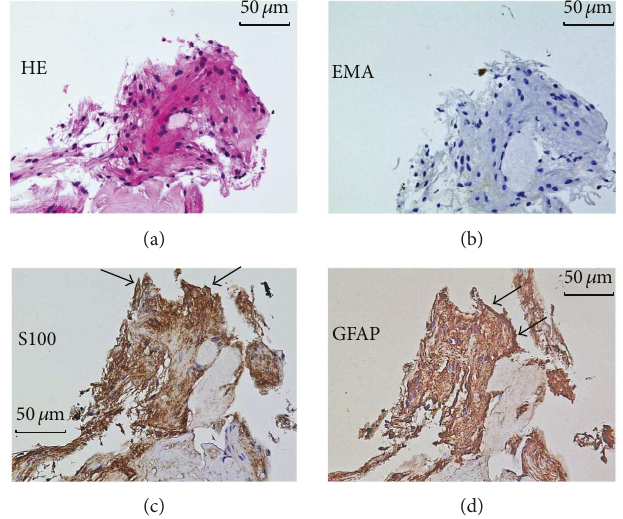
Figure 7: Histology (a) and immunohistochemistry (b – d) of a resected epipapillary membrane tissue in case 4. (a) Light micrograph demonstrating marked hyalinization. Spindle-shaped stromal cells were intermingled in the section (hematoxylin-eosin). (b) Immunochemistry for cytokeratin. Immunoreactivity was not observed. (c) Immunoreactivity for S100 was detected in the membrane (arrows). (d) Immunoreactivity for GFAP was strongly detected in the membrane (arrows).